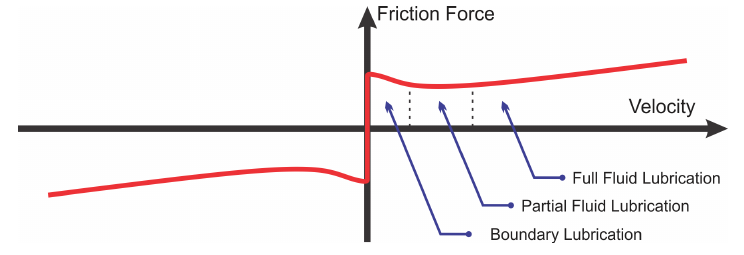
Figure 4. Stribeck effect